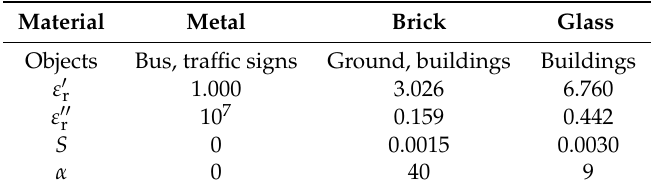
Table 1. EM (electromagnetic) parameters in RT (ray-tracing) simulations. Material Metal Brick Glass